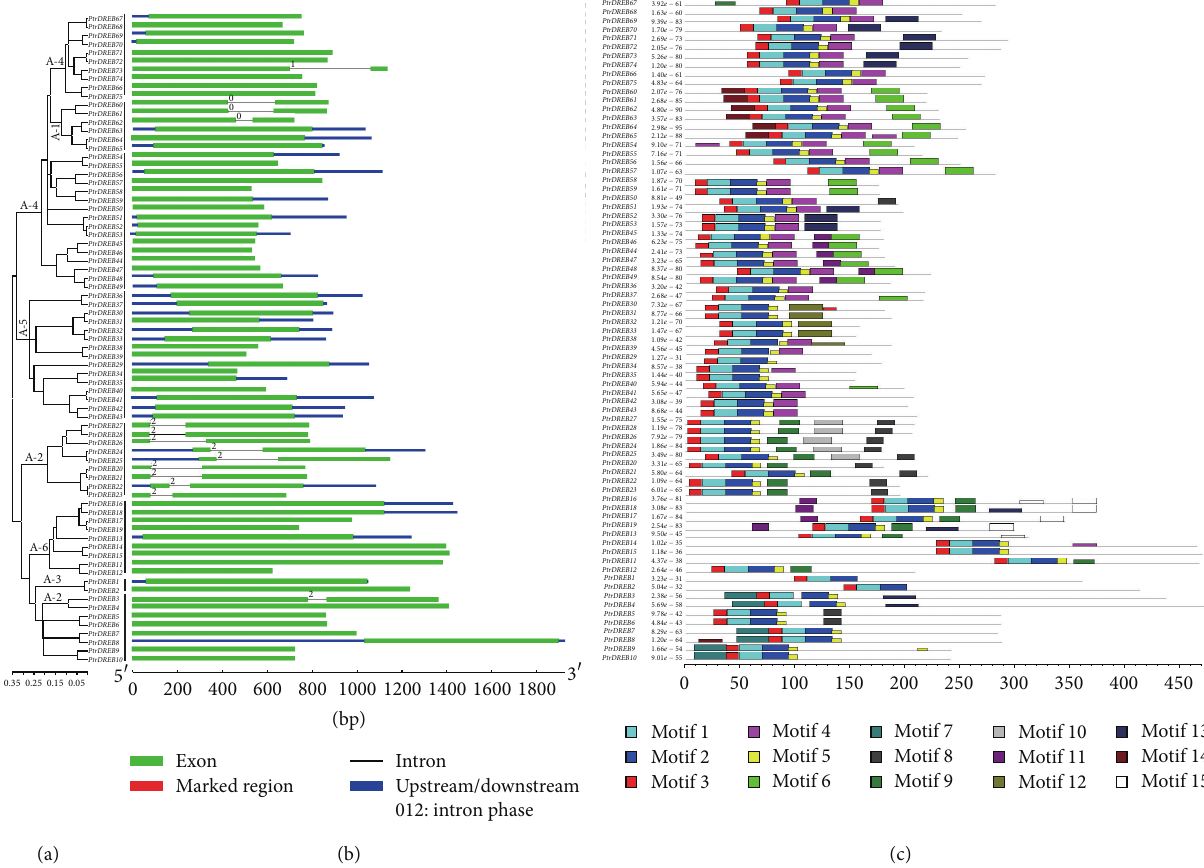
Figure 4: Phylogenomic analysis of 75 DREB genes in P. trichocarpa (a) with the integration of exon/intron structures (b) and MEME motifs (c). Exon/intron structure was obtained from the Gene Structure Display Server. Motifs were identified with the MEME software using the complete amino acid sequences of the DREB